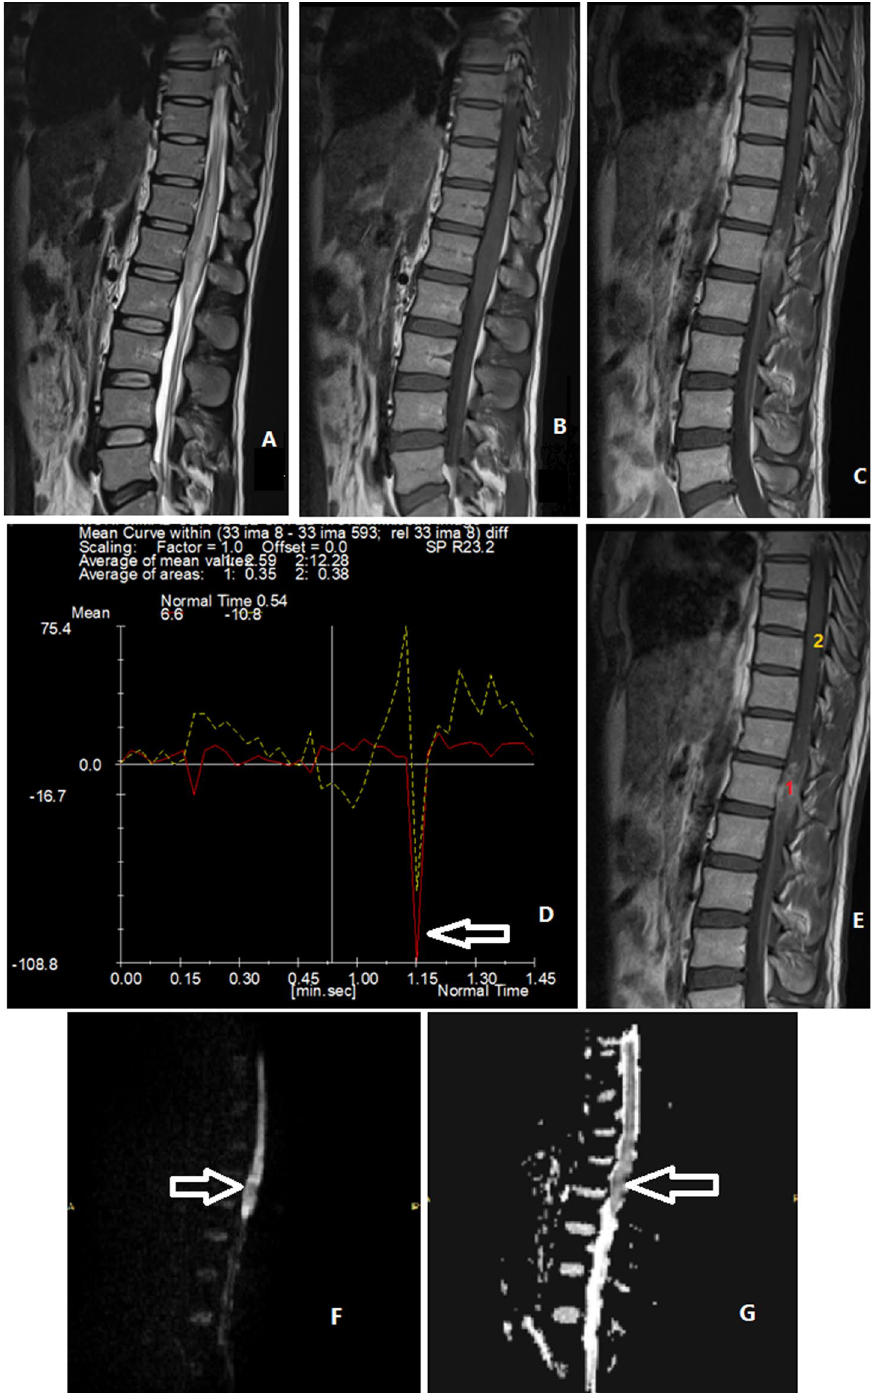
Fig. 2 29-year-old male presented with bilateral lower limb weakness. T2 sagittal dorso-lumbar spine ( A ) shows spinal cord expansion with high signal intensity. Pre-contrast T1 ( B ) and post ‑ contrast T1 ( C ) show expansion of spinal cord with isointense signal and heterogeneous post-contrast enhancement. D and E rCBV was calculated in comparison to normal cord (yellow curve) and the curve shows hyper perfusion of the lesion (arrow to red curve). DWI at b value 1000 ( F ) shows hyperintensity of the lesion (arrow) which looks also hyperintense at ADC map (arrow at G ) denoting = free diffusion. This lesion was diagnosed ependymoma (low